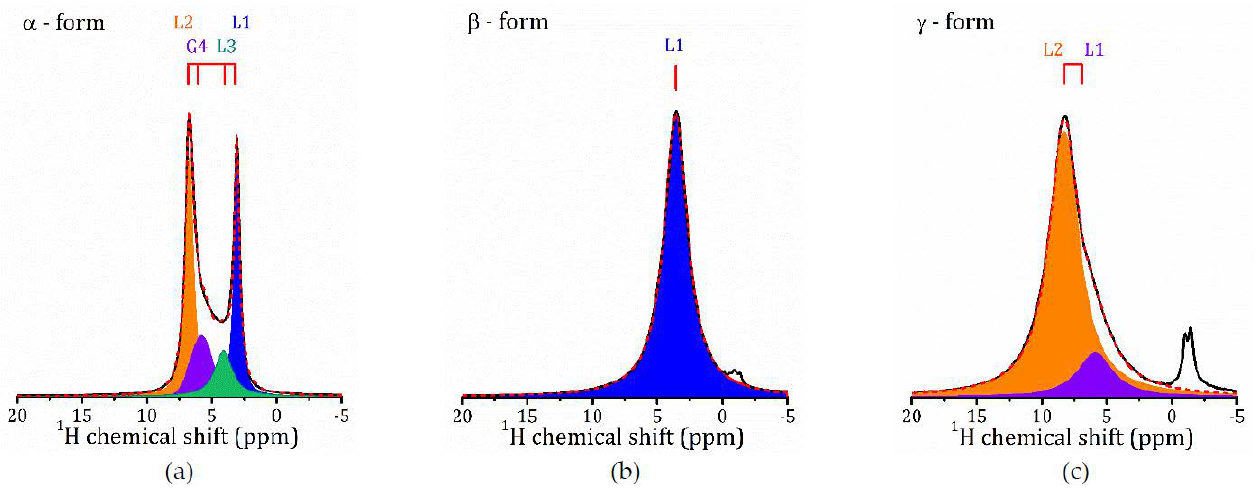
Figure 3. 1 H MAS NMR spectra in the α - ( a ), β - ( b ), and γ -forms ( c ) of HCa 2 Nb 3 O 10 · y H 2 O at 297 K. At room temperature (297 K), the 1 H spectrum of α -HCa 2 Nb 3 O 10 (Figure 3a) consists of two narrow intense Lorentzian lines at 3.1 and 6.8 ppm, L1 and L2, respectively, and two lines of lower intensities: Lorentzian line L3 at about 4.1 ppm and Gaussian line G4 at 6.0 ppm. For β -HCa 2 Nb 3 O 10 (Figure 3b), it consists of only one rather broad Lorentzian line at 3.6 ppm, whereas for γ -HCa 2 Nb 3 O 10 (Figure 3c), the main signal is observed at 8.2 ppm (L2), with a shoulder at 5.9 ppm (L1) (a signal at about − 2 ppm can be associated with surface defects and is not discussed